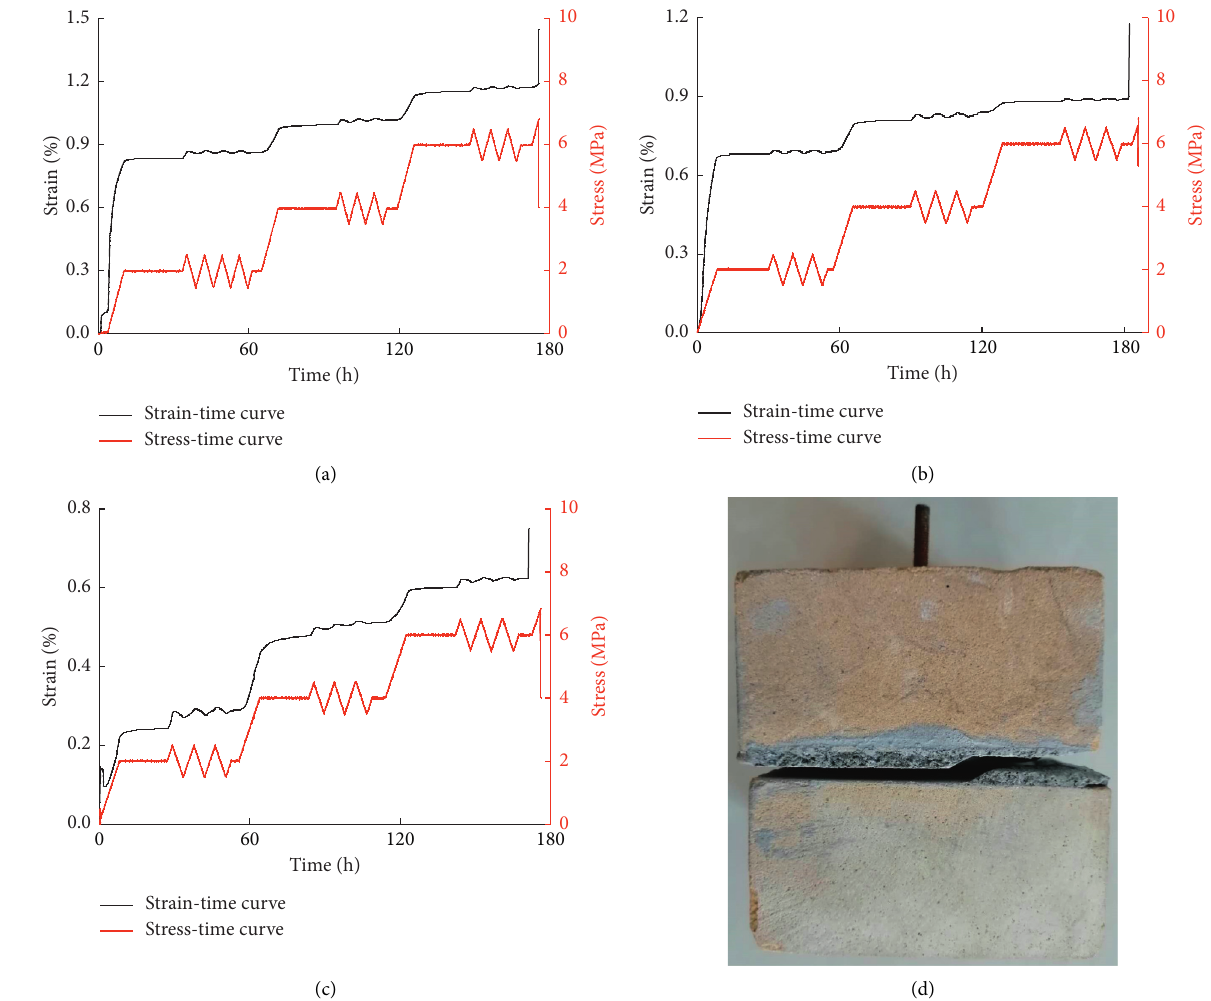
Figure 4: Time-dependent curves of strain and stress under different rock strengths and failure specimen. (a) Anchored sandstone rock masses. (b) Anchored marble rock masses. (c) Anchored granite rock masses. (d) Failure specimen.